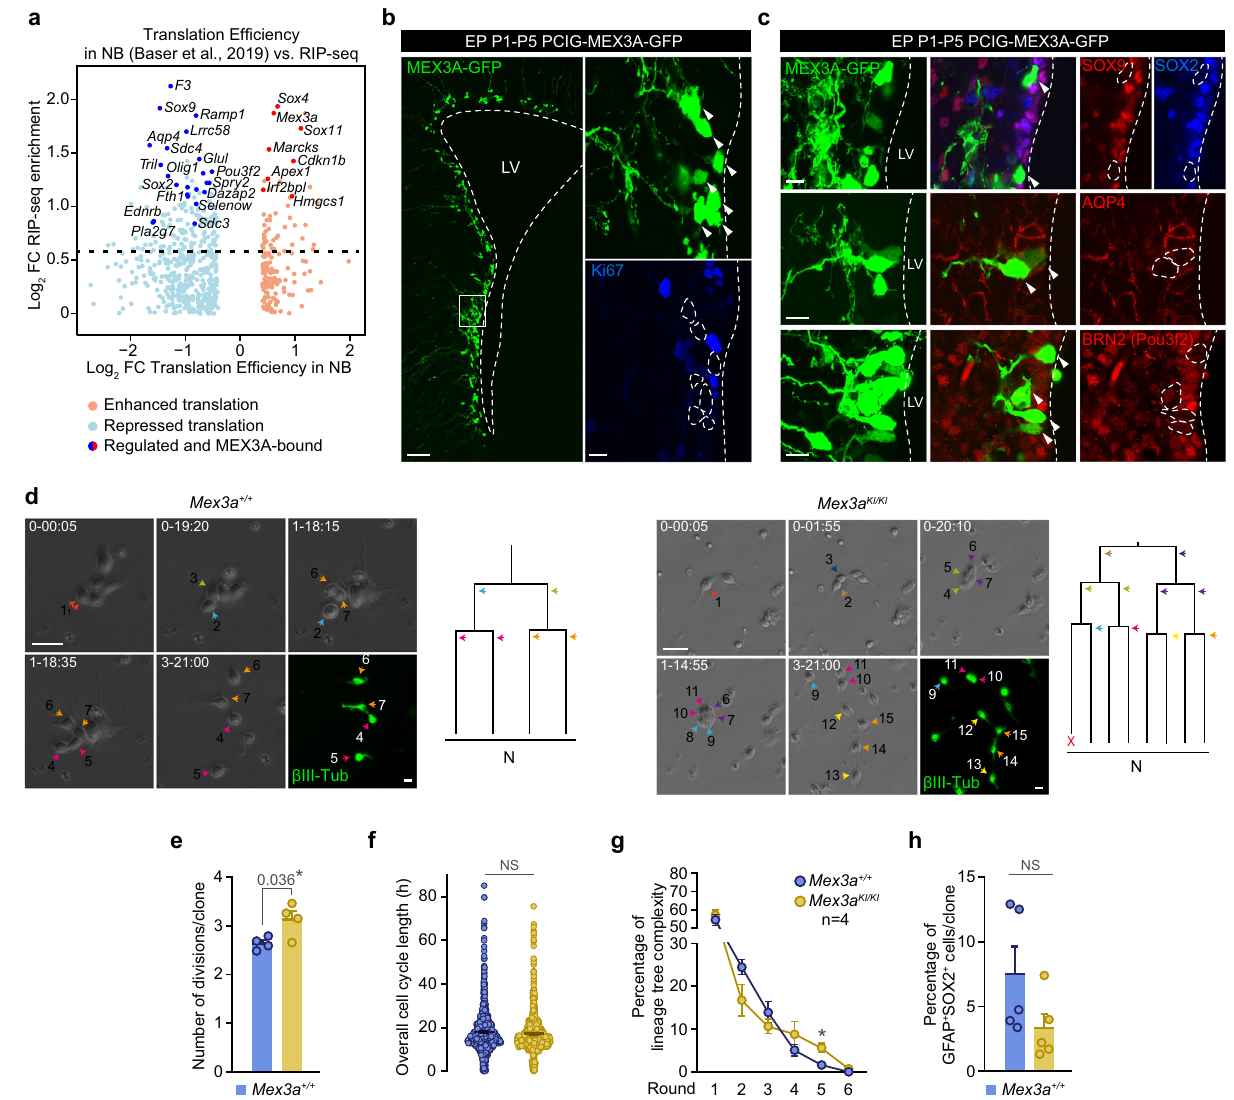
Fig. 5 | Dysregulation of the MEX3A targetome at the onset of differentiation leads to hyperproliferation. a Scatterplot comparing MEX3A RIP-seq enrichment data with translation ef fi ciency data from SEZ and OB NBs 17 . Red dots represent geneswithenhancedtranslationwhereasbluedotsrepresentgeneswithrepressed translation. Dark red and blue dots label translationally regulated genes that are also bound by MEX3A.Four additionalgenes bound byMEX3A( Apoe, Mmp14,Tpt1 and Zfp219 ) showed uncoupled translation in NBs but differed between SEZ and OB, so they are not shown in the plot. b MEX3A-GFP signal (green) in the lateral ventricleofP5mice4daysafterpostnatalday1(P1)electroporation(EP)withPCIG- MEX3A-GFP (left). Ki67 (blue) expression in MEX3A-GFP + electroporated cells (right). c Immunohistochemistry showing protein downregulation of MEX3A tar- gets Sox9 (red), Sox2 (blue), Aqp4 (red)and Pou3f2 (BRN2,red)afteroverexpression of MEX3A-GFP. d Representative phase contrast images of Mex3a +/+ and Mex3a KI/KI individualclonesobtainedbyvideotime-lapsemicroscopyatdifferentpoints(day- hour:minute) (left). Immunostaining for ßIII-tubulin (green) at the endpoint shows